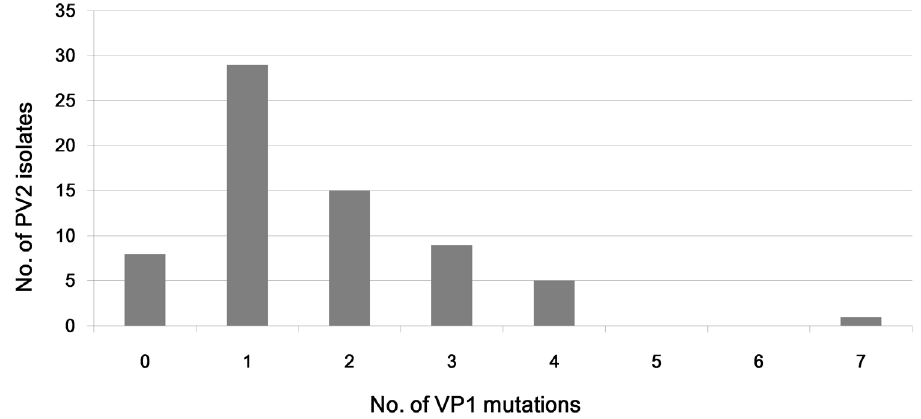
Figure 2. VP1 mutation numbers of environmental PV2 in Shandong from May 2012 to June 2013.